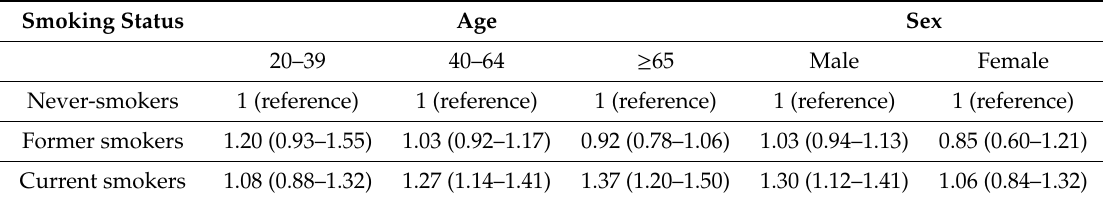
Table 4. Subgroup analyses of risk of malignant glioma, according to age and